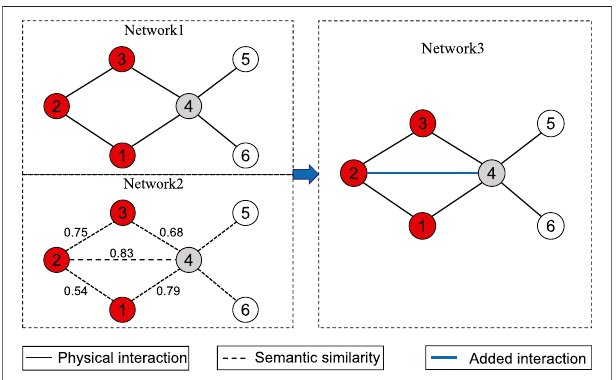
FIGURE 1 | An illustrative example of the suggested adding link operator. Network 1 is the original network, where the red nodes denote disease proteins 1 , 2 and 3 in S , and the gray node 4 representsa neighbor of nodes in S , and node 4 is a strong-linked node; Network 2 represents the semantic similarity network, where the marked edge weights are the semanticsimilarity.Network3representstheadjustednetwork,wherealinkis added between nodes 2 and 4